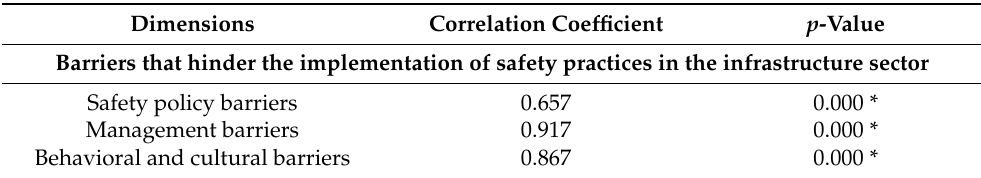
Table 3. Structure validity of the questionnaire. Dimensions